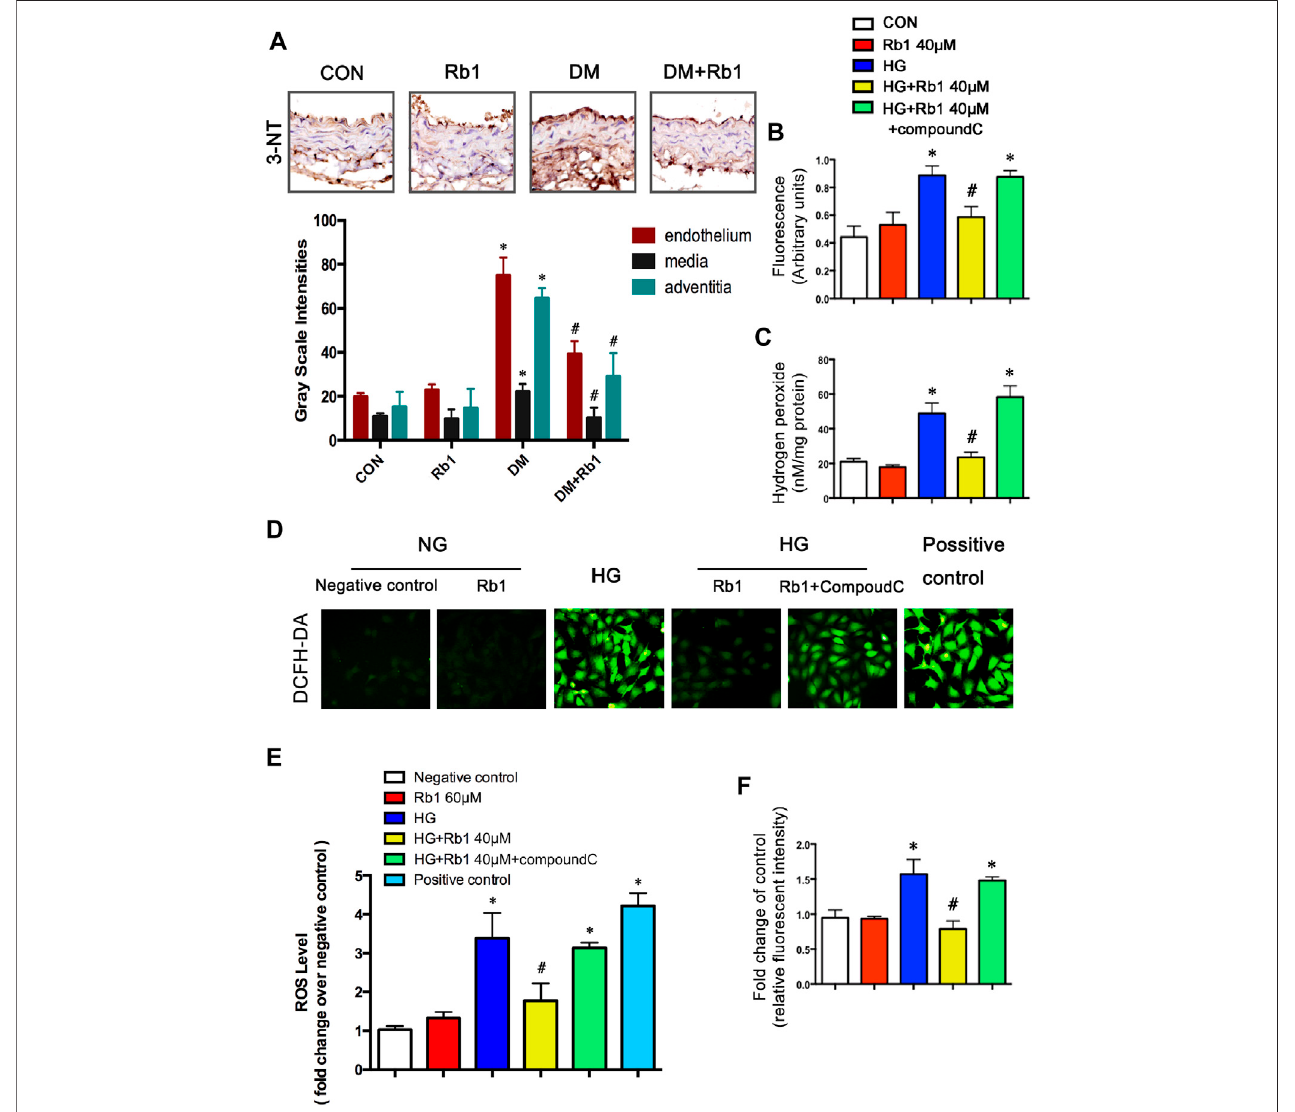
FIGURE 6 | Rb1 improves DM and HG-induced oxidative stress. (A) Immunohistochemical staining and semiquantitative analysis of 3-nitrotyrosine (3-NT). ROS was assessed by three different methods: (B) DCFH-DA, (C) Amplex Red, and (F) DHE in VSMCs (D) ROS levels. in each group. Original magni fi cation × 200. (E) Semiquantitative analysis of ROS levels in each group. The positive control is the active oxygen donor from the DCFH-DA kit, which contains H 2 O 2 . Data are mean ± SEM. n (cid:2) 5 – 6, * p < 0.05 vs. Control; # p < 0.05 DM + Rb1 vs. DM and HG + Rb1 vs. HG.